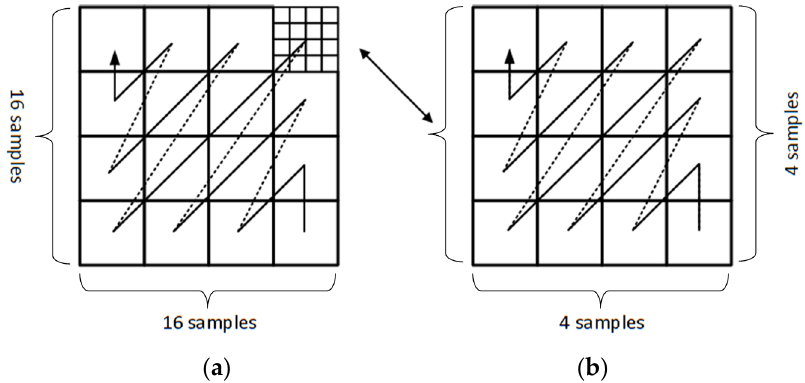
Figure 3. Diagonal scanning: ( a ) in large transform block, and ( b ) within 4 × 4 transform block.